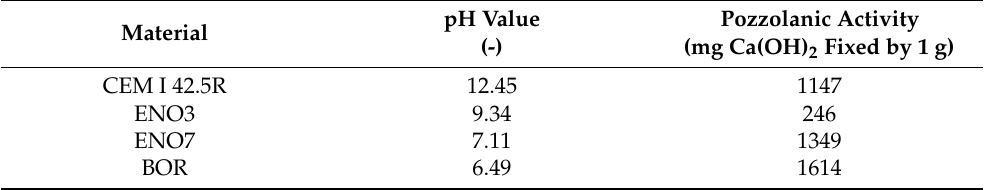
Table 7. Physico-chemical properties of tested